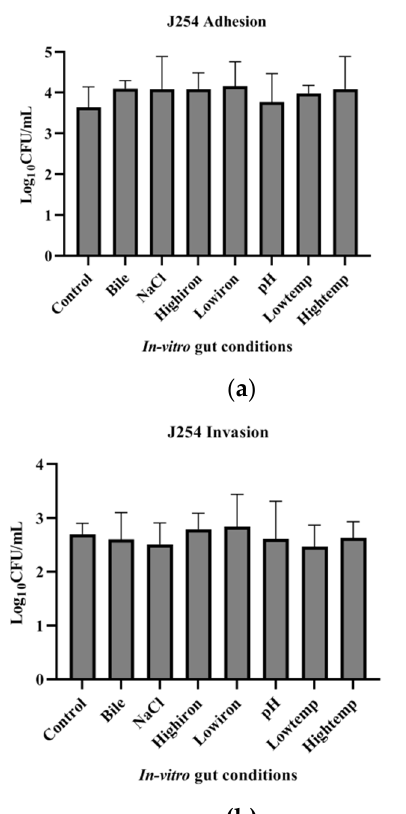
Figure 8. Effect of in vitro gut conditions on adhesion and invasion ability of sensitive isolate J254 to Caco-2 cell lines. Error bars represent standard deviations from triplicates. Unpaired t -test was performed and p < 0.05 was considered significant. ( a ) Effect of in vitro gut conditions on adhesion ability of sensitive isolate (J254). ( b ) Effect of in vitro gut conditions on invasion ability of sensitive isolate